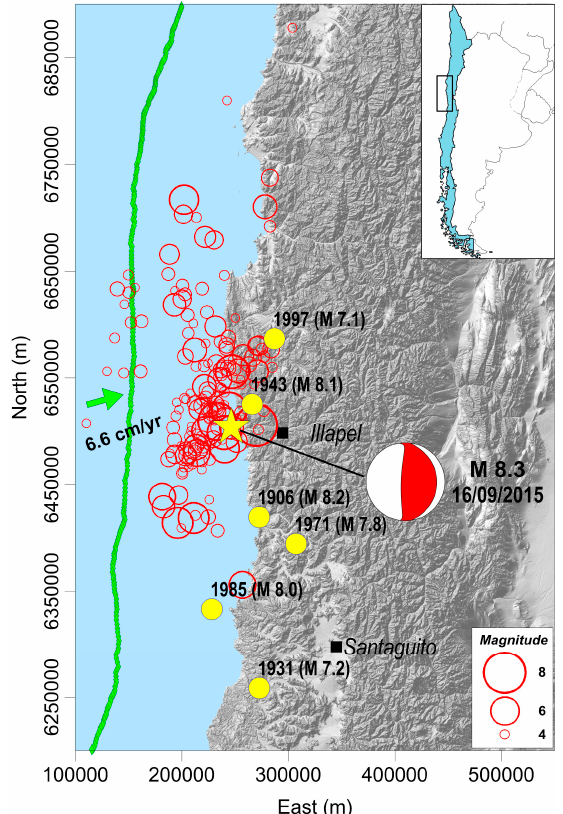
Figure 1. Map of seismicity in the Illapel region reporting the earthquakes from 30 August to 19 September 2015, with M > 4 (red circles): the epicenter of the main shock is outlined with the yellow star, and its focal mechanism is also represented. Yellow dots show the past most energetic earthquakes of the area. The solid green line indicates the trench axis position, while the green arrow shows the direction of motion of the Nazca Plate towards the South American Plate [3]. The upper right inset shows the location of the epicentral area.